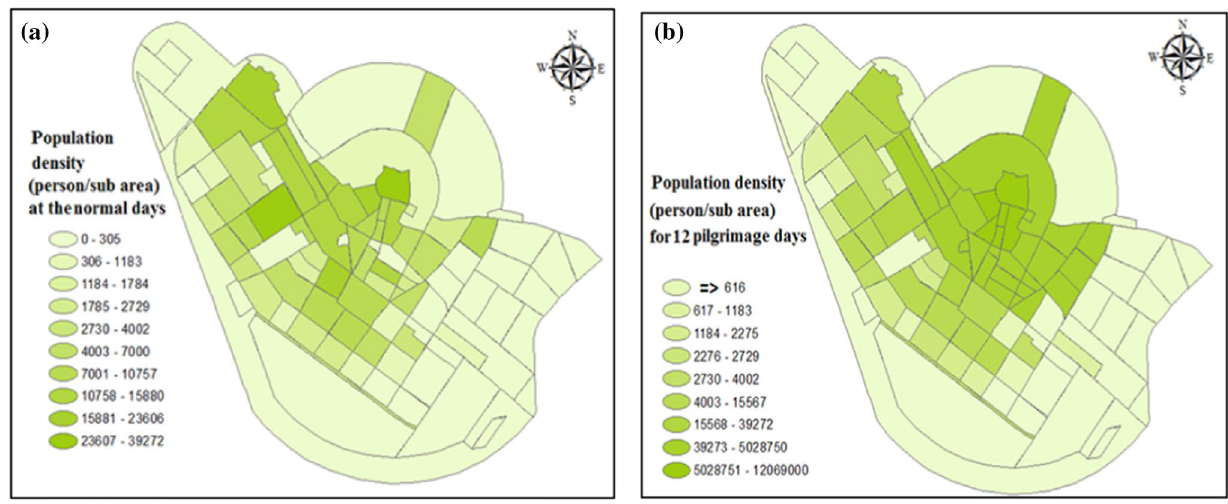
Fig. 4 a Distribution of permanent population; and b during 12 pilgrimage days (Arbaeen visit) of Karbala